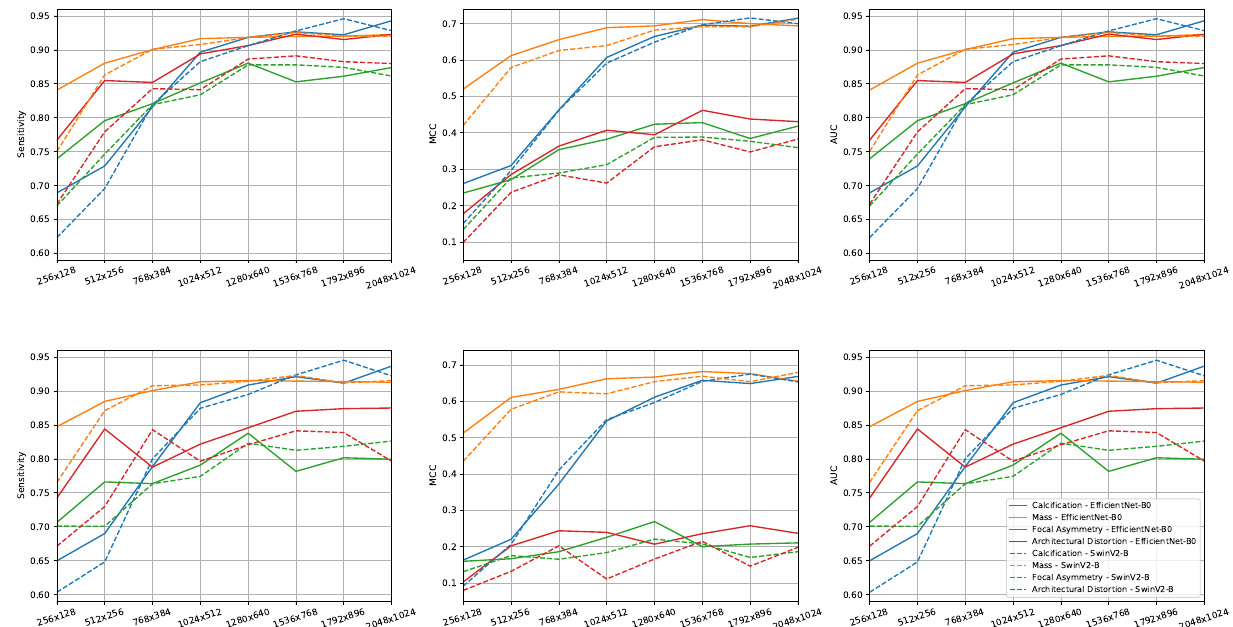
Figure 5. ROC curves of EfficientNet-B0 and SwinV2-B-W8 for all input resolutions used. In the legend the AUC value for each ROC curve is reported.